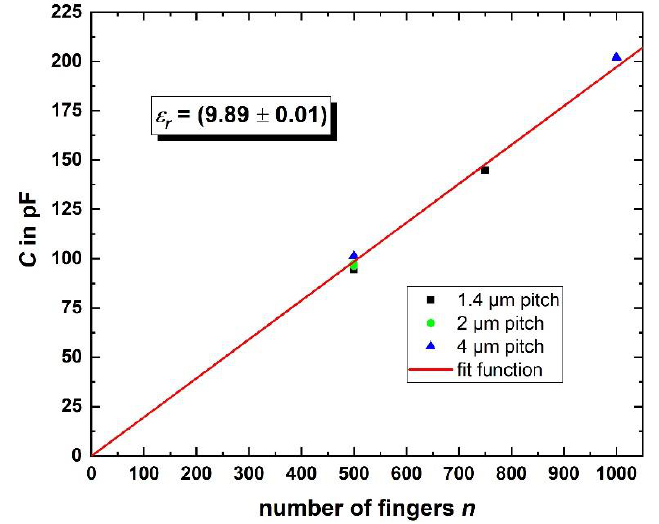
Figure 10. Measured capacitance of the investigated IDCs with different pitches. With a linear fit function according to Equation (2), the effective dielectric constant of the capacitors’ dielectric can be estimated.